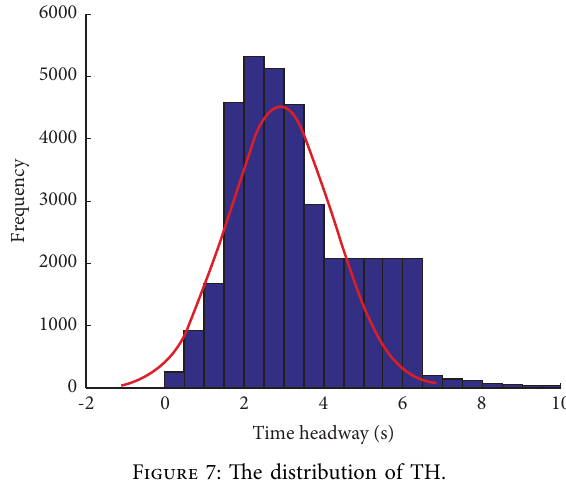
Figure 7: Te distribution of